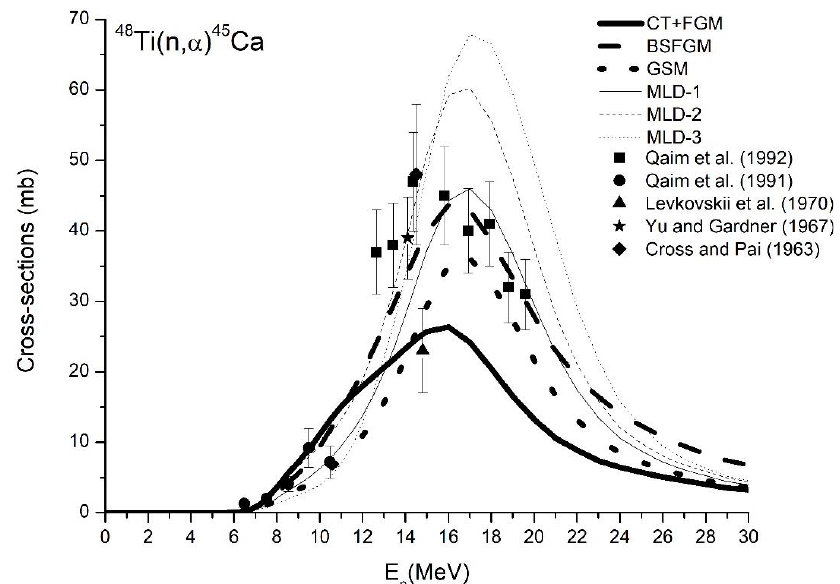
Figure 3: Comparison of the theoretically calculated excitation functions with the